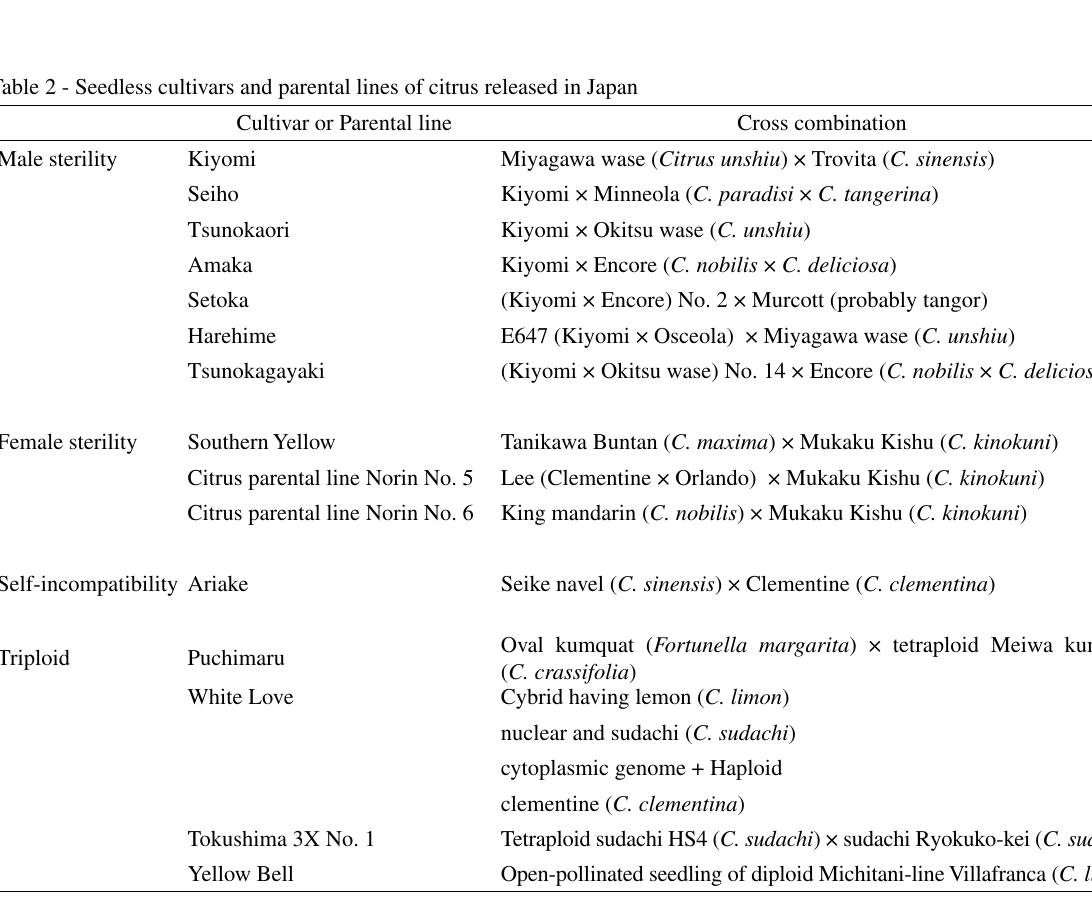
)Fig. 2 - Male-sterile seedless citrus